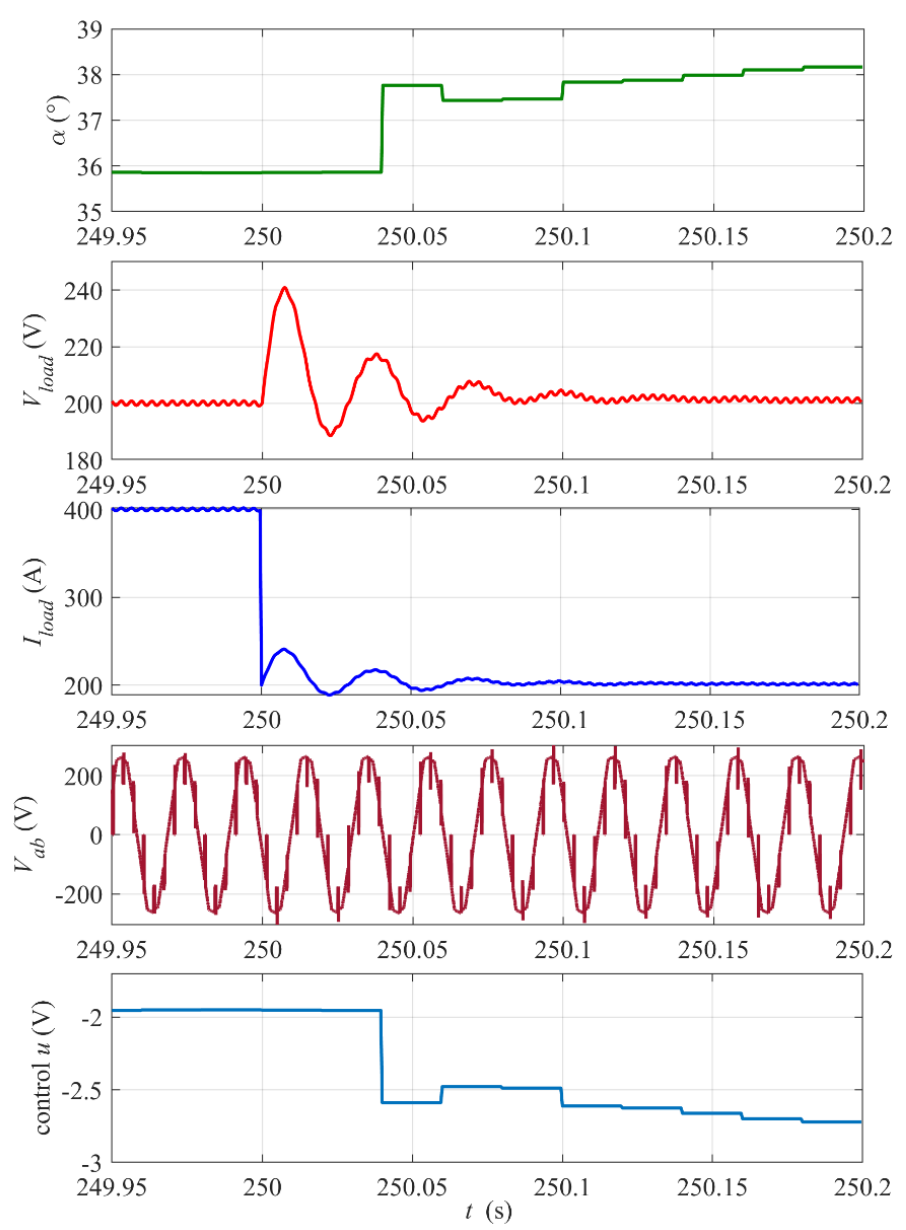
Figure 12. Zoomed-in view of waveforms from Figure 11 around the step instant t step = 250. The Figure 12. Zoom ed- in view of waveforms from Figure 11 around the step instant t step = 250. The digital control update period T sc = 20 digital control update period T sc = 20 ms.